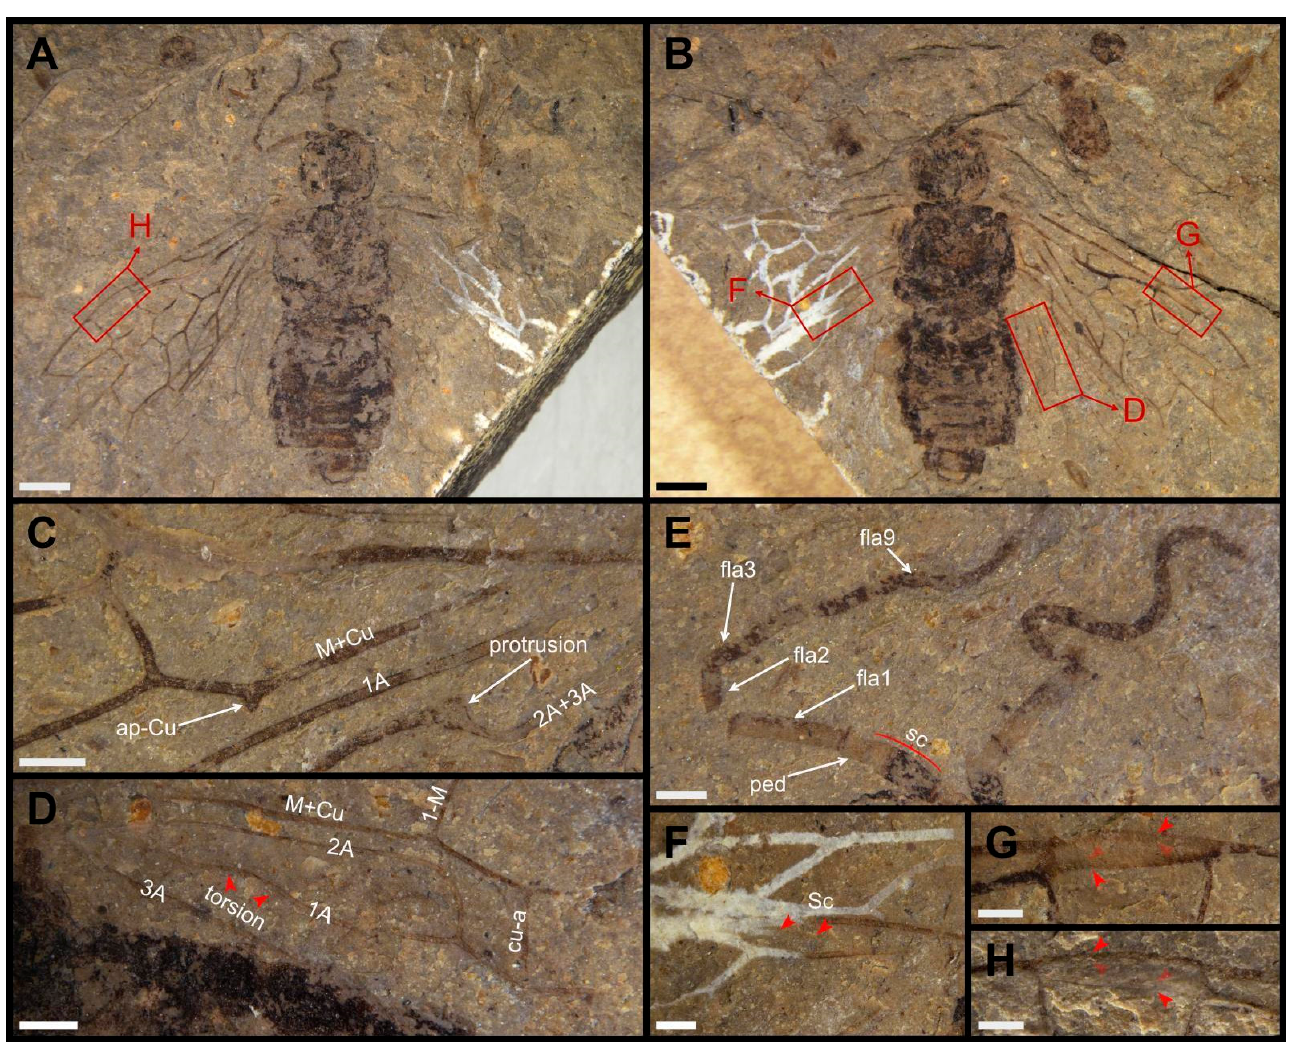
curved near the middle. The base of vein 2A+3A having a protrusion at the bend close to Material. Holotype, CNU-HYM-ND2022105p/c (part and counterpart; Figures 1 and vein 1A (Figure 1C). Cell 2a almost 3.5 times as long as wide.